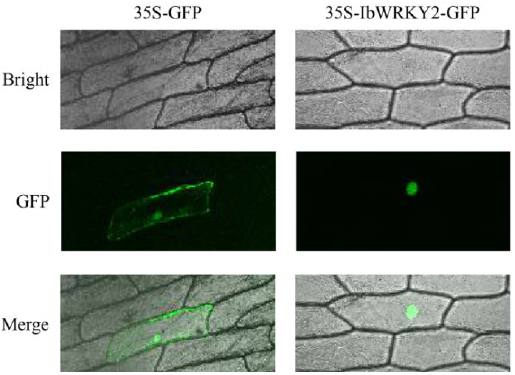
Figure 4. Subcellular localization of IbWRKY2 in onion epidermal cells. Confocal scanning microscopic images show that the IbWRKY2-GFP fusion protein localized to the nuclei (in the right column) vs. GFP as the control (in the left column).